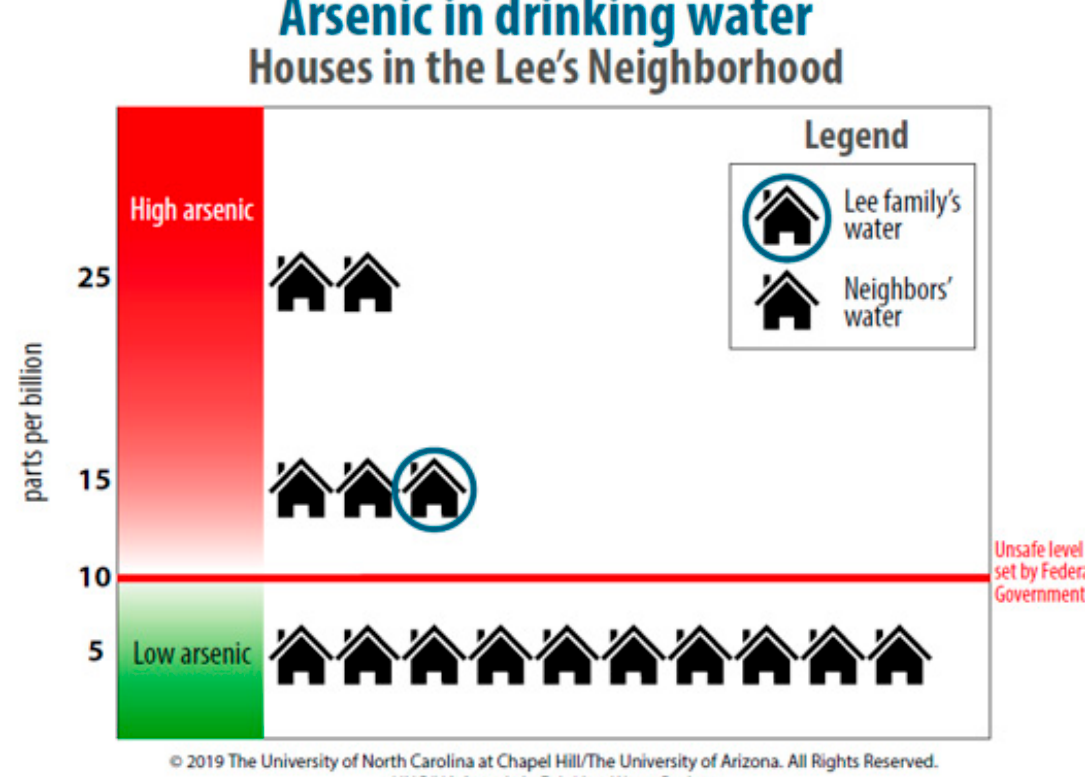
Figure 1. Hypothetical Well Water Report.